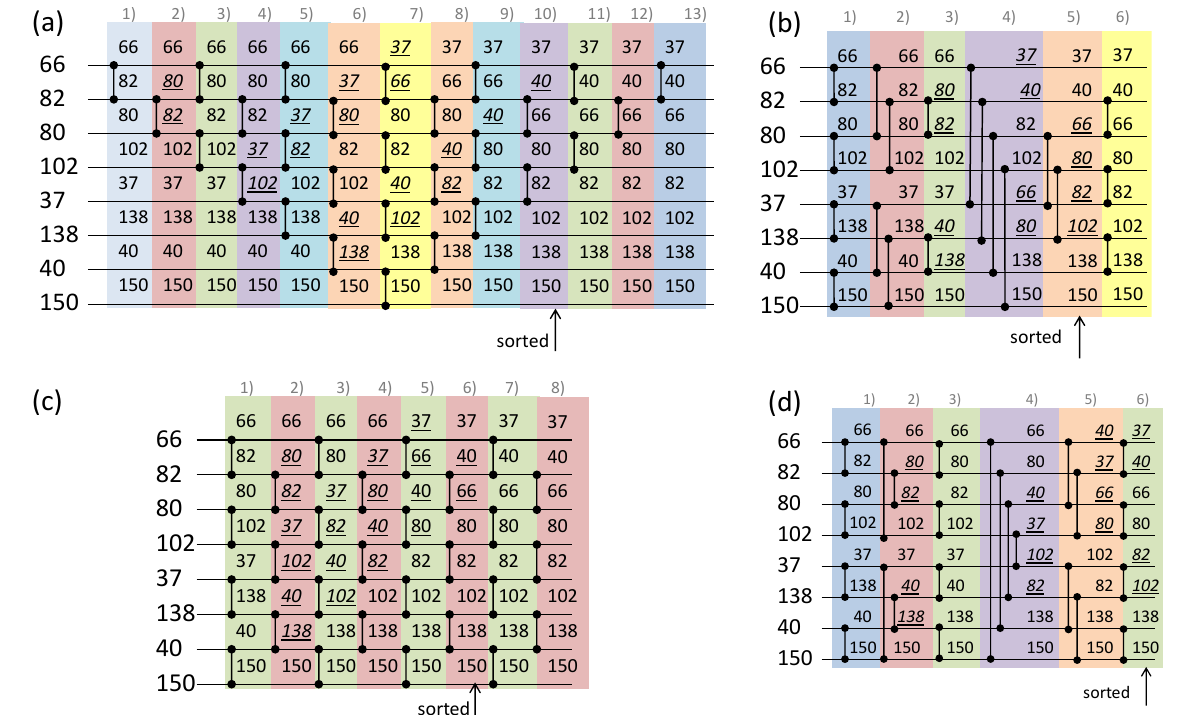
Figure 1. Sorting networks for ascending sort of eight data items: bubble network ( a ); even–odd merge network ( b ); even–odd transition network ( c ); and bitonic merge network ( d ). When a comparator swaps input data items, these are underlined and shown in italics.